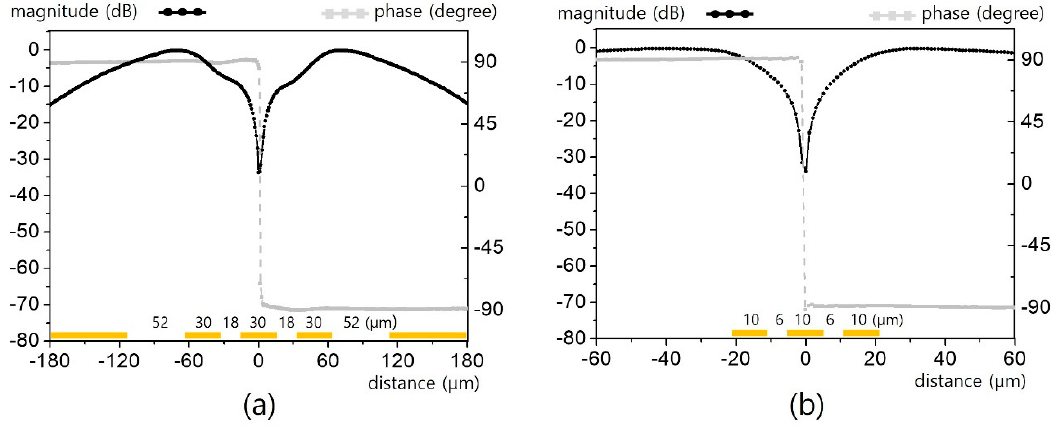
Figure 5. Horizontal electric field distribution over narrow triple ( n = 3) CPW lines: ( a ) for L/g/G = 30/18/52 μ m, and ( b ) for L/g/G = 10/6/52 μ m.